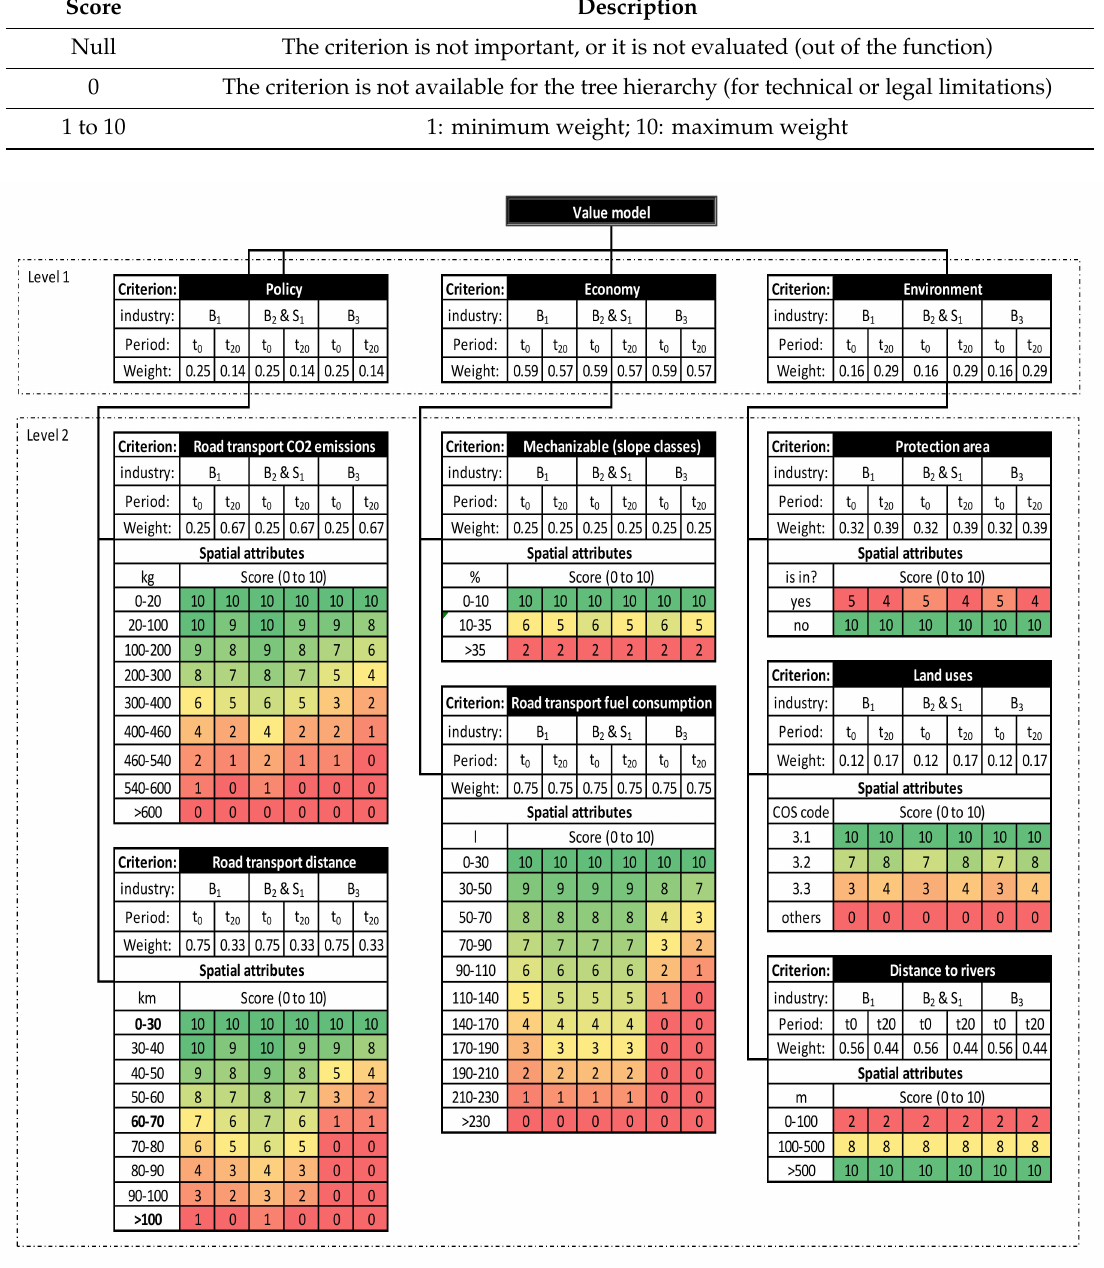
Figure 5. Value model for B1, B2 / S1 and B3 industries in the Nordeste region, Portugal, based on AHP. Red and green represent the lowest (0) and the highest (19) score values for criteria level / alternative per industry, respectively. Other colors in the red-green gradient represent intermediate